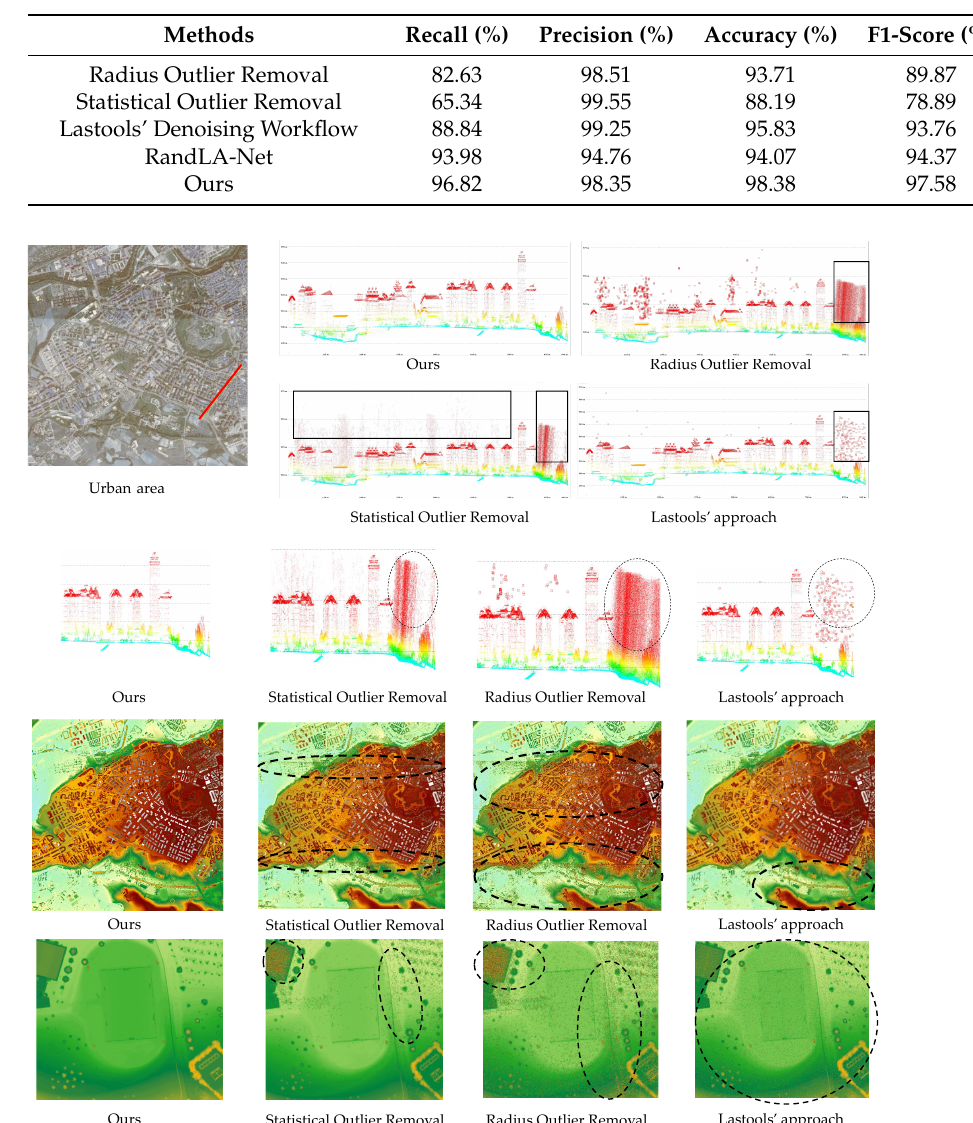
Table 2. Performance evaluation of the compared approaches and ours in the urban area.